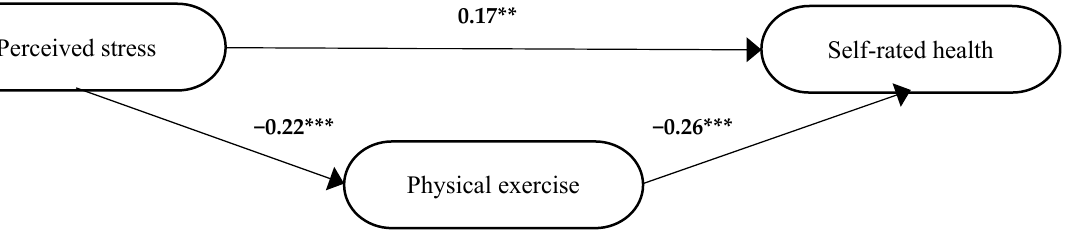
Figure 6. The final model for participants who reported two of the requested diagnoses. The standardized beta coefficients ( β ) for the different paths between the independent variable, i.e., perceived stress, the mediator, i.e., physical exercise, and the dependent variable, i.e., self-rated health. ** p ≤ 0.01, *** p ≤ 0.001.